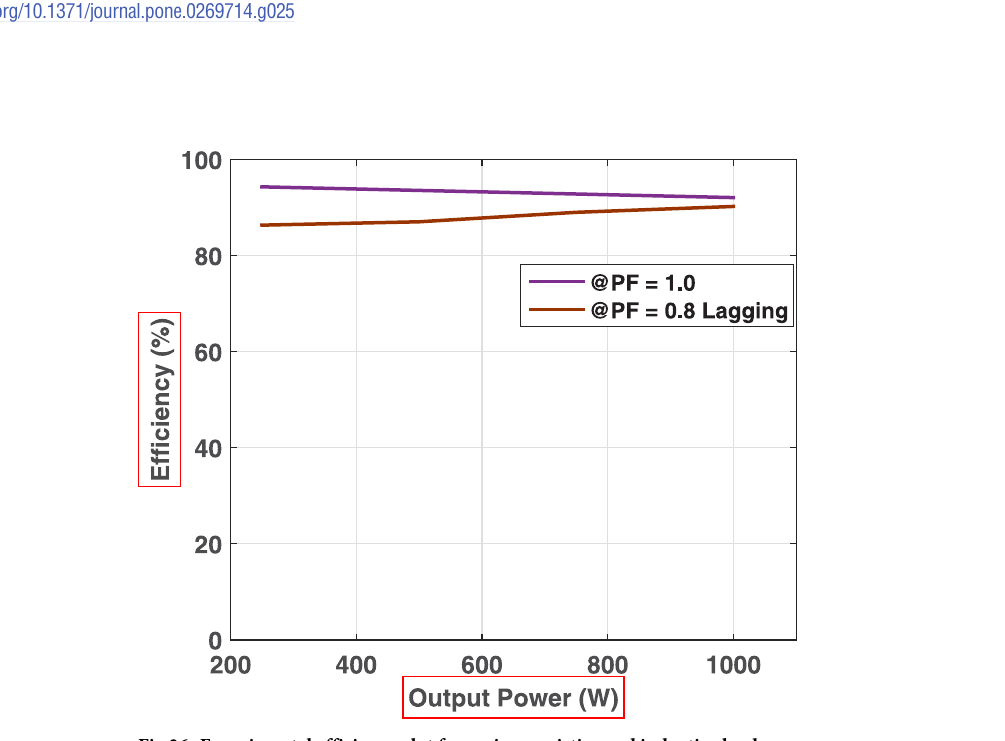
PLOS ONE | https://doi.org/10.1371/journal.pone.0269714 June 22,